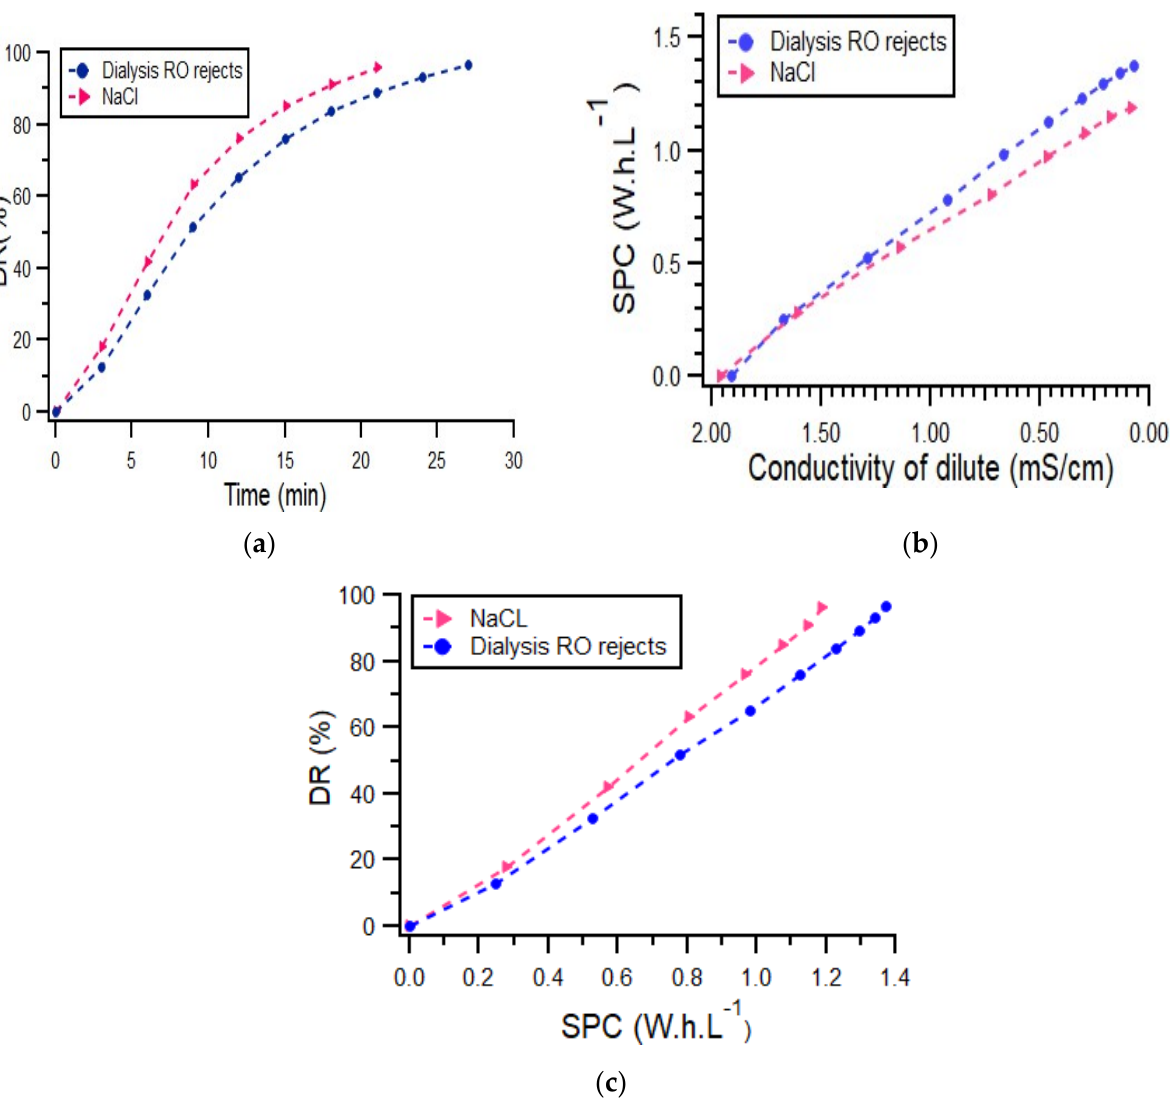
Figure 6. ( a ) DR (%) time course during processing of 1 L of NaCl and dialysis RO rejects; ( b ) SPC (Wh · L − 1 ) consumed for the treatment 1 L of NaCl and dialysis RO rejects as a function of the conductivity (mS · cm − 1 ); ( c ) Relationship between DR and SPC for the same experiments.